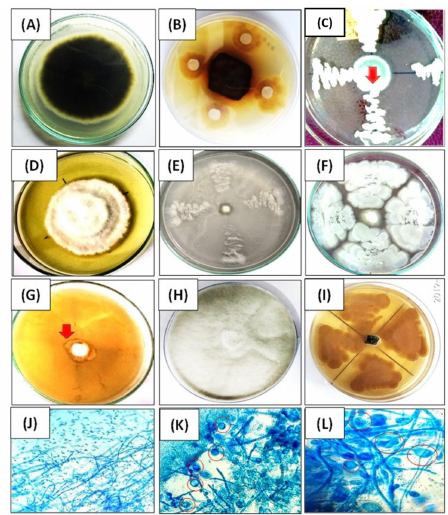
Figure 5. Antagonistic activity of the bacterial endophytes as determined in dual culture plates: ( A ) control plate of A. alternata ; ( B ) AKAD A1-16 against A. alternata ; ( C ) AKAD A1-1 against A. alternata ; ( D ) control plate of F. oxysporum ; ( E ) AKAD A1-1 against F. oxysporum ; ( F ) bacterial strain AKAD A1-2 against F. oxysporum ; ( G ) AKAD A1-16 against F. oxysporum ; ( H ) control plate of M. phaseolina ; ( I ) AKAD A1-16 against M. phaseolina ; ( J ) microscopic observation of the con- trol mycelium of F. oxysporum ; ( K ) inhibition zone of AKAD A1-16 against F. oxysporum (40 × ); ( L ) inhibition zone of AKAD A1-16 against F. oxysporum (100 × ) (red circles represents chlamydospore